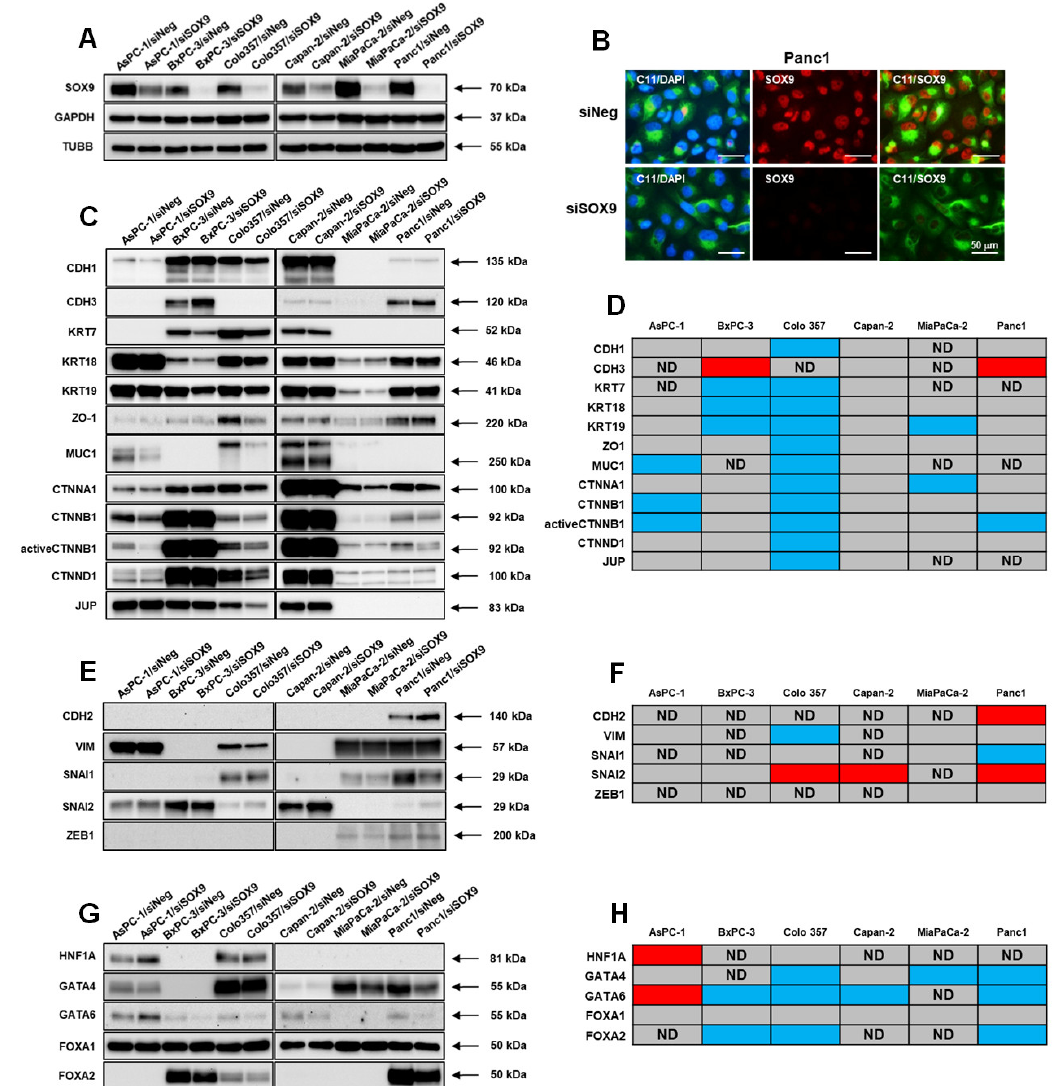
Figure 2. The effect of SOX9 downregulation on the expression levels of protein markers of differentiation and developmental transcription factors in pancreatic cancer cells. ( A ) Western blot analysis of the expression of SOX9 in AsPC-1, BxPC-3, Colo357, Capan-2, MiaPaCa-2, and Panc1 cells transfected with control siNeg and siSOX9 ( n = 3). GAPDH and beta-tubulin (TUBB) were used as loading and normalization controls. ( B ) Immunofluorescence imaging of the SOX9 expression in Panc1 cells transfected with control siNeg and siSOX9. Cells were stained for total cytokeratin (green) and SOX9 (red). Nuclei were stained with DAPI (blue). Scale bar = 50 µ m. ( C ) Western blot analysis of the expression of epithelial cell protein markers in the investigated cell lines transfected with control siNeg and siSOX9 ( n = 3). ( D ) Heatmap of differentially expressed epithelial cell proteins from ( C ). Color code: red, upregulation; blue, downregulation; gray, no change. ND = undetected expression. ( E ) Western blot analysis of the expression of mesenchymal cell protein markers in the investigated cell lines transfected with control siNeg and siSOX9 ( n = 3). ( F ) Heatmap of differentially expressed mesenchymal cell proteins from ( E ). Color code: red, upregulation; blue, downregulation; gray, no change. ND = undetected expression. ( G ) Western blot analysis of the expression of developmental transcription factors in the investigated cell lines transfected with control siNeg and siSOX9 ( n = 3). ( H ) Heatmap of differentially expressed developmental transcription factors from ( G ). Color code: red, upregulation; blue, downregulation; gray, no change. ND = undetected